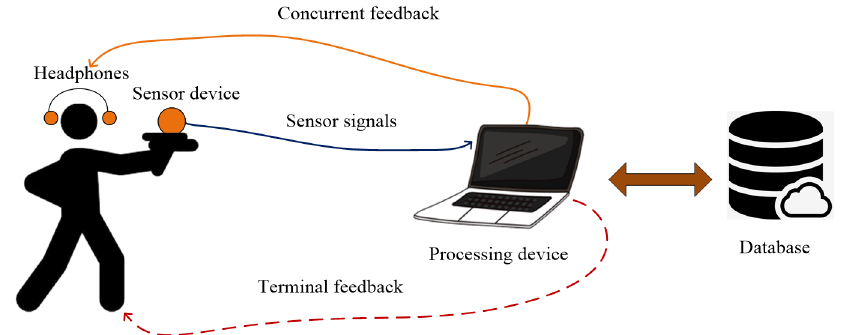
Figure 1. The distributed architecture of the biofeedback system. The acquired sensor signals are processed by the processing device. The user can receive concurrent feedback on unwanted or excessive hand movements (solid arrows) or terminal feedback on the shooting results (dashed arrow). All signals and processed data are stored in the database.